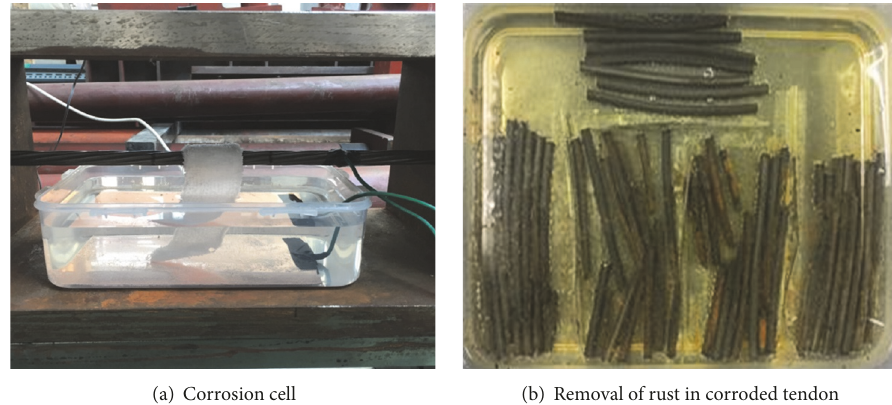
Figure 2: Corrosion cell and rust removal process.